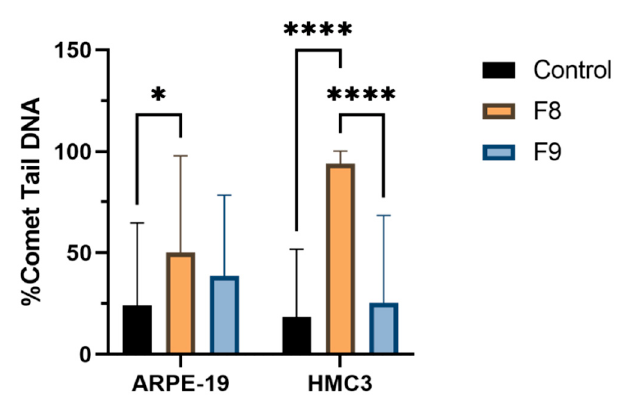
Figure 5. Genotoxic effects induced by F8 and F9 nanoemulsions in ARPE-19 and HMC3 cell lines. The bars indicate the % of DNA in the comet tail (mean ± SD). Mean was calculated by the OpenComet software. Statistical significance: * p < 0.05; **** p < 0.0001.